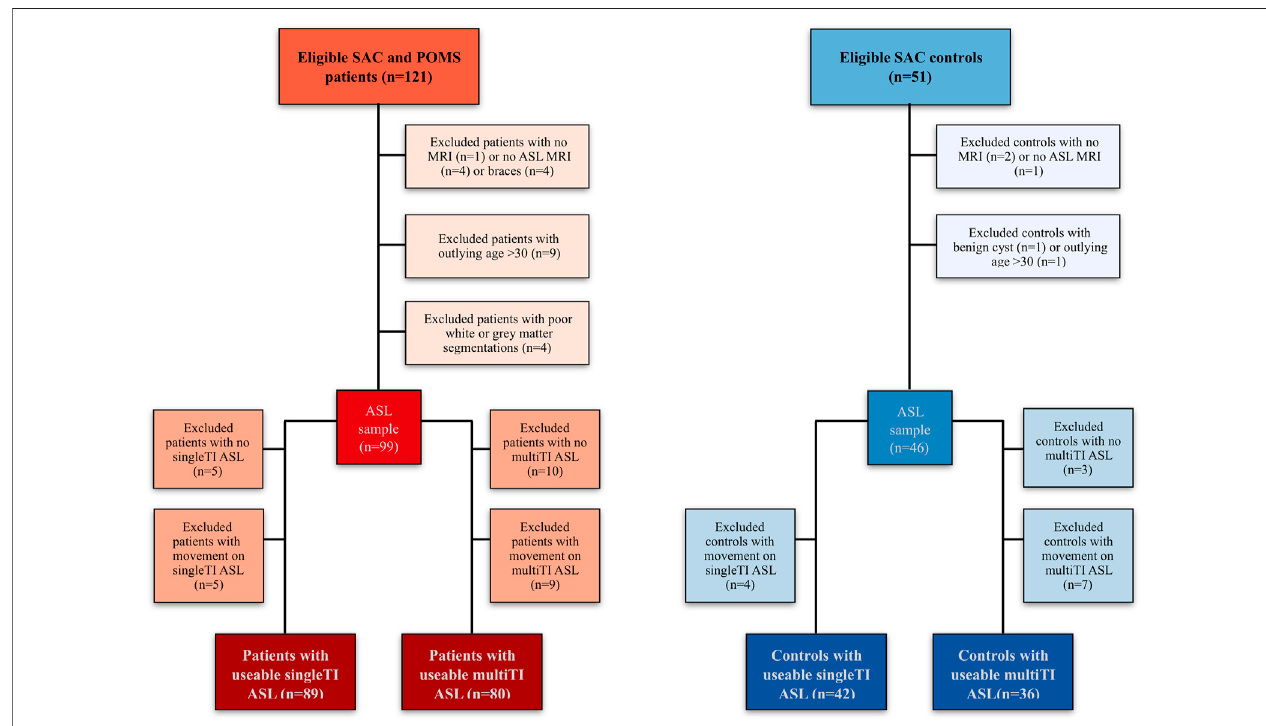
FIGURE 3 | Participant fl ow-chart. Visualization of reasons for participant exclusion (Stotesbury et al., 2022). Note that while most participants had usable data for both sequences (N = 75 patients, n = 36 controls), others only had usable data for the single TI sequence ( n = 14 patients, n = 6 controls), or the multiTI sequence ( n = 5 patients,0controls).ASLArterialSpinLabeling;MRImagneticresonanceimaging;POMS,PreventionofMorbidityinSickleCellDisease;SAC,SleepAsthmaCohort;TI, in fl ow